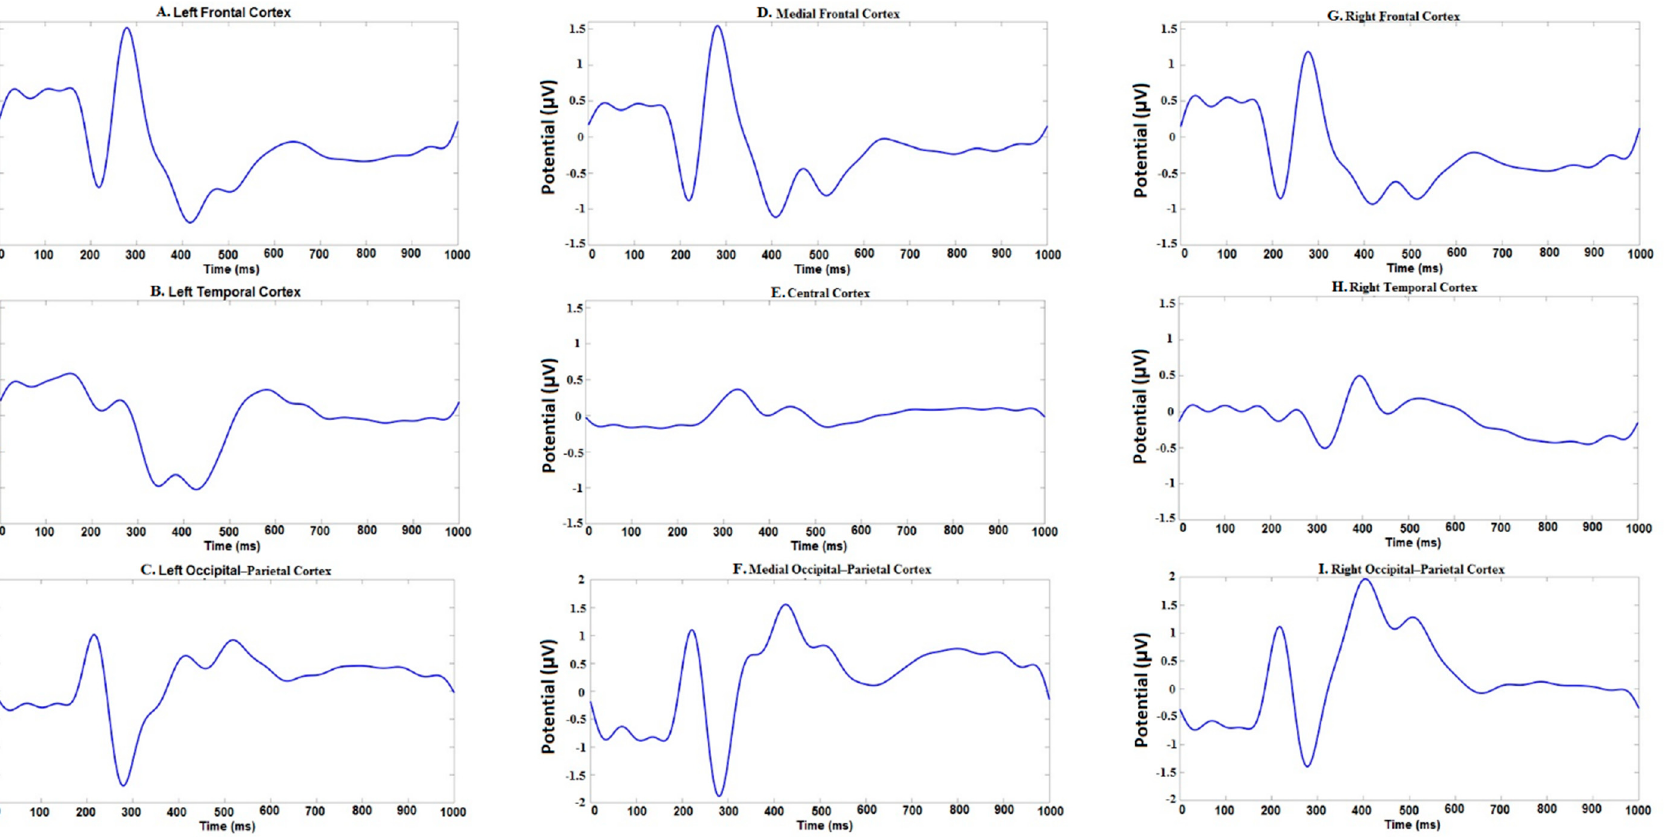
Figure 3. Time-amplitude plots of event-related potential (ERP) in 9 cortical regions of interest averaged across all participants.